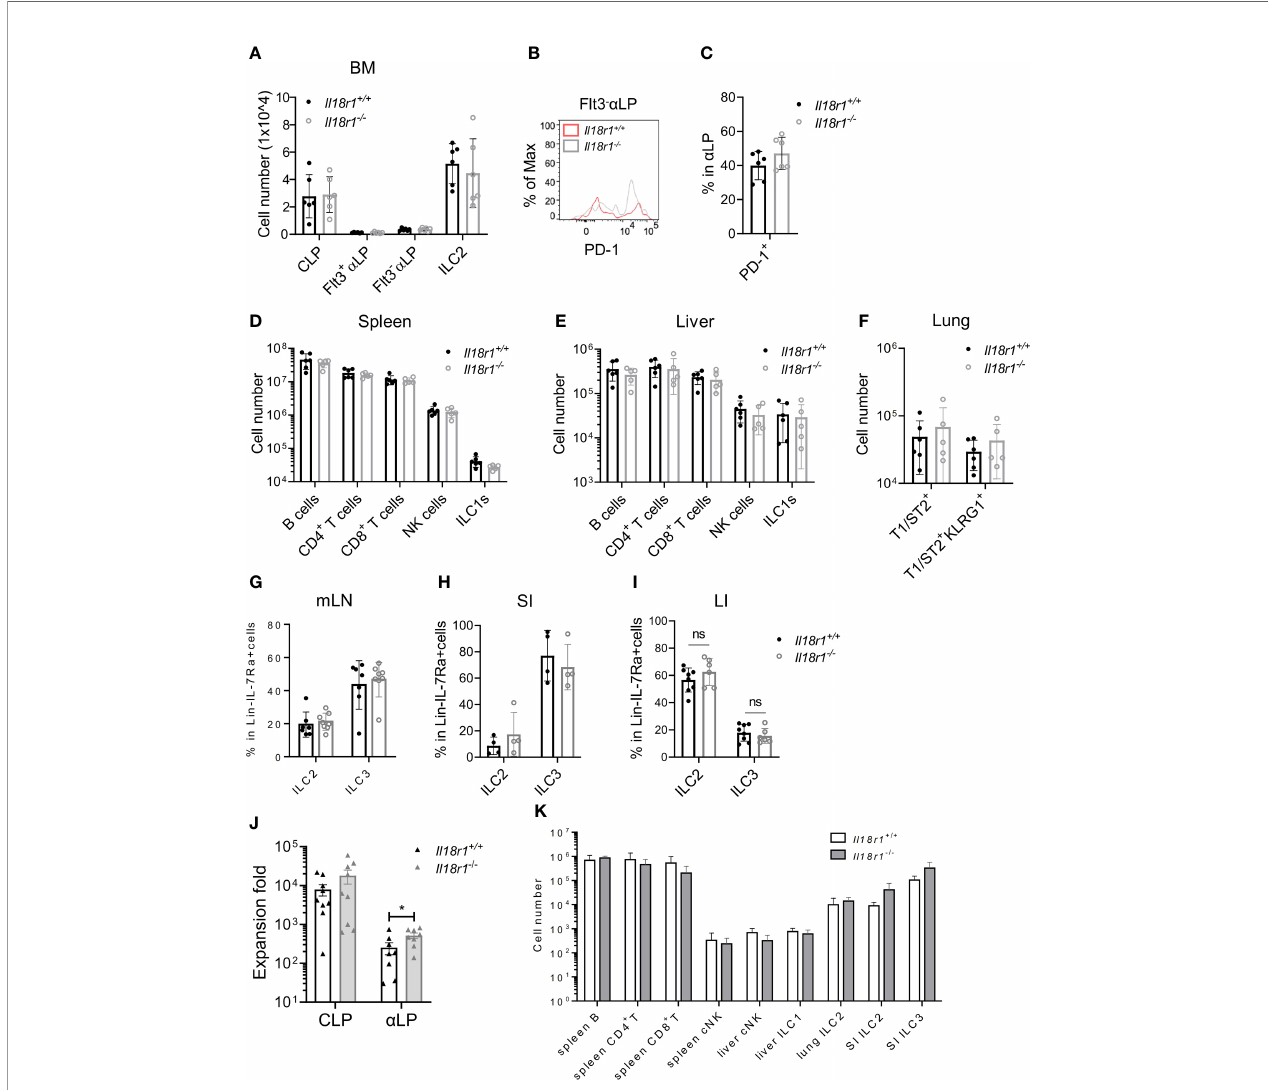
FIGURE 6 | ILC development in the absence of IL18R a signaling. (A) Numbers of BM progenitors and ILC2 from Il18r1 +/+ and Il18r1 -/- mice. (B) Representative FACS plot showing the expression of PD-1 in Flt3 - a LP from Il18r1 +/+ and Il18r1 -/- BM. (C) Percentage of PD-1 + in a LP from Il18r1 +/+ and Il18r1 -/- mice. (D, E) Numbers of B cells, CD4 + T cells, CD8 + T cells, NK cells, and ILC1s in the spleen and liver from Il18r1 +/+ and Il18r1 -/- mice. (F) Number of total T1ST2 + ILC2 and activated T1ST2 + KLRG1 + ILC2 in the lung of Il18r1 +/+ and Il18r1 -/- mice. (G – I) Percentage of ILC2 and ILC3 in mesenteric lymph nodes, small intestine, and large intestine from I Il18r1 +/+ and Il18r1 -/- mice. (J) Cell expansion of Il18r1 +/+ and Il18r1 -/- BM CLP (50~200 cells) and a LP (100~300 cells) after culture on OP9-DL1 with 20 ng/ml SCF and 20 ng/ml IL-7 for 14 days. (K) Reconstitution of lymphoid cell compartment in Rag2 -/- Il2r g -/- mice adoptively transferred with Il18r1 +/+ and Il18r1 -/- BM CLPs. Data are representative of two independent experiments with three mice in each group. The data are presented as mean ± SEM, analyzed by two-tailed Student ’ s t-test. “ nc ” = negative control, meaning no added IL-18 in culture system. * p < 0.05; ** p < 0.01; *** p < 0.001; **** p <